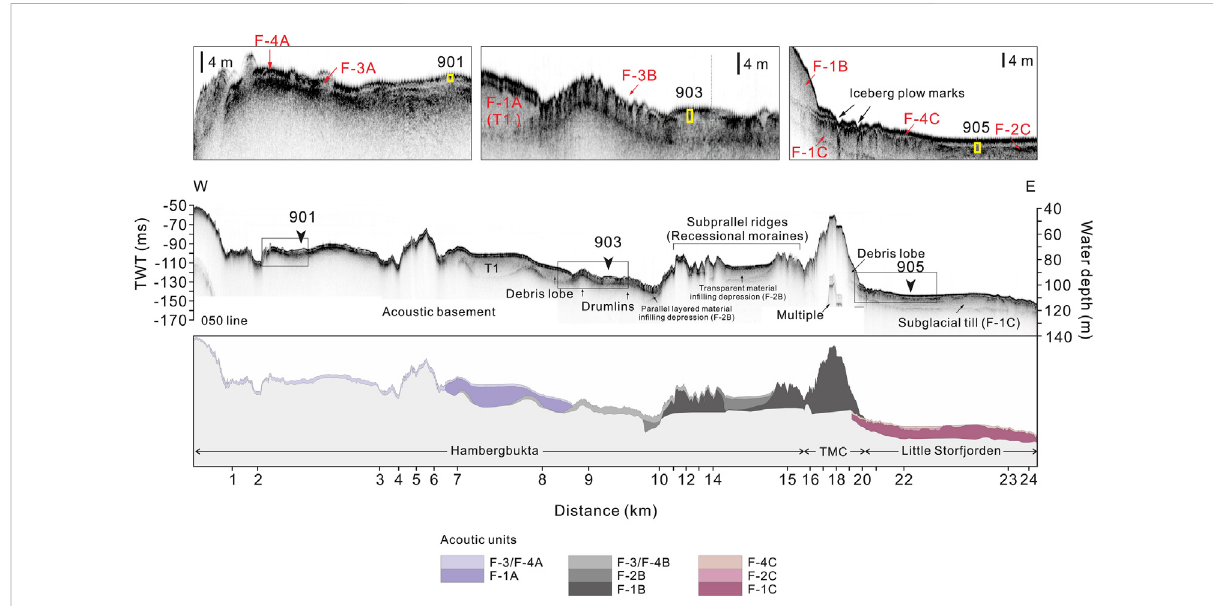
FIGURE 4 Acoustic units (F-1 to F-4) de fi ned in an SBP 050 line. Yellow boxes in panel (A) show the penetration depths for the studied cores. For the locations of gravity cores, see Figure